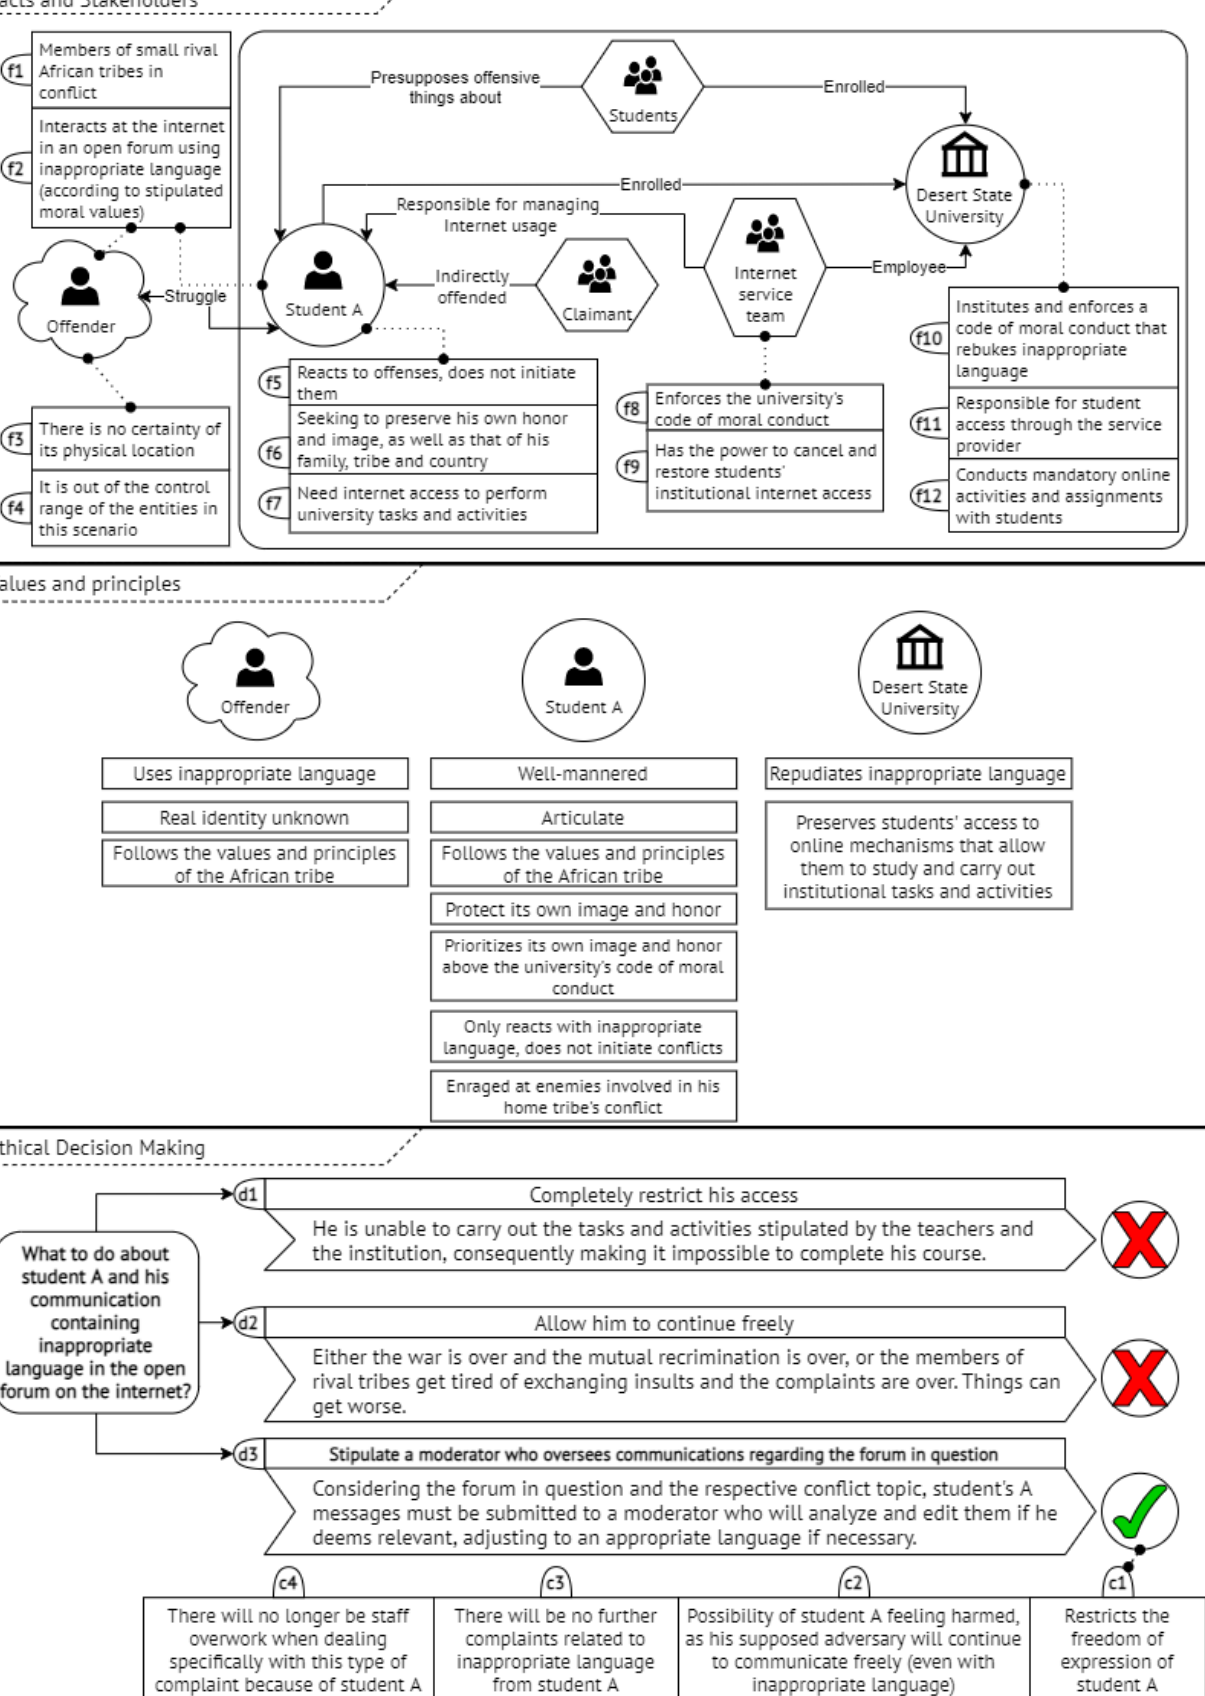
Figure 5. Online Cultural Conflict Masiero (2013) case